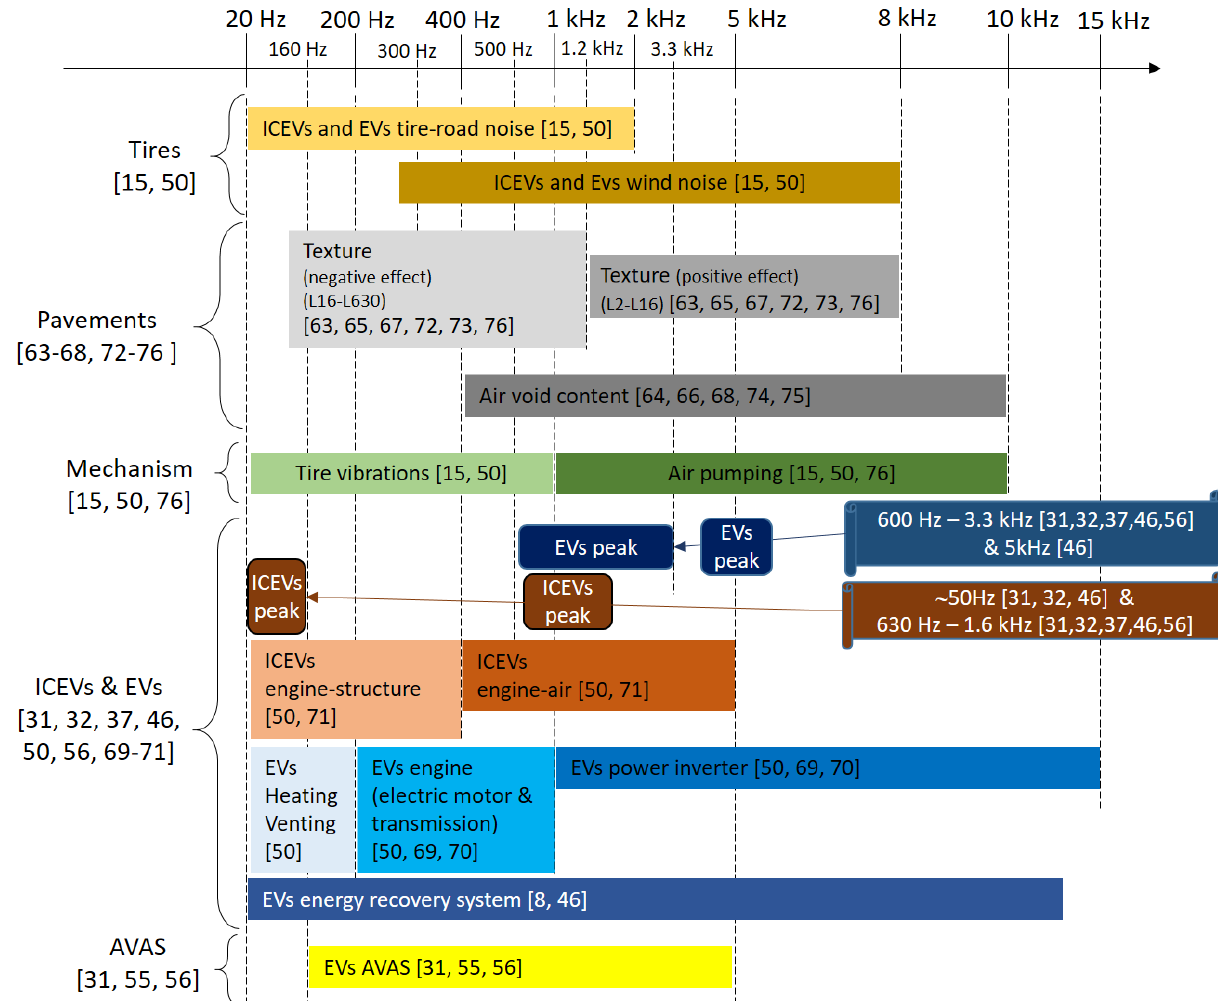
Figure 8: EVs versus ICEVs from a low-noise pavement perspective [8, 31, 32, 37, 45, 50, 52, 55, 56,